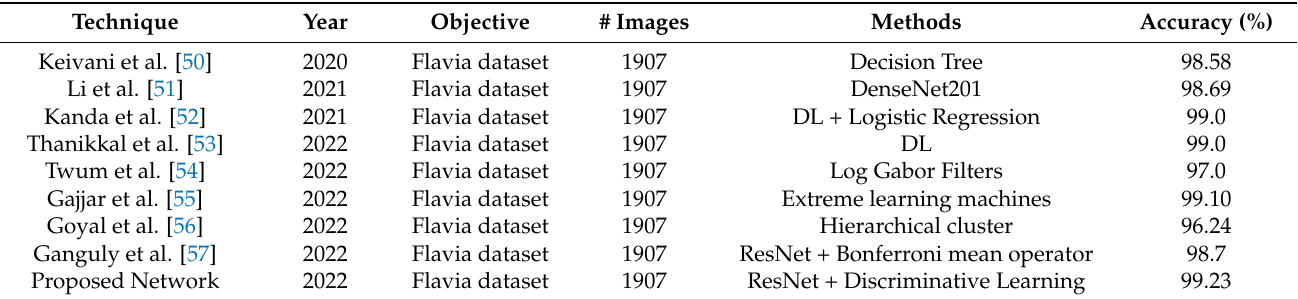
Table 10. Comparison of the proposed technique with the existing prevalent approaches on the Flavia dataset.